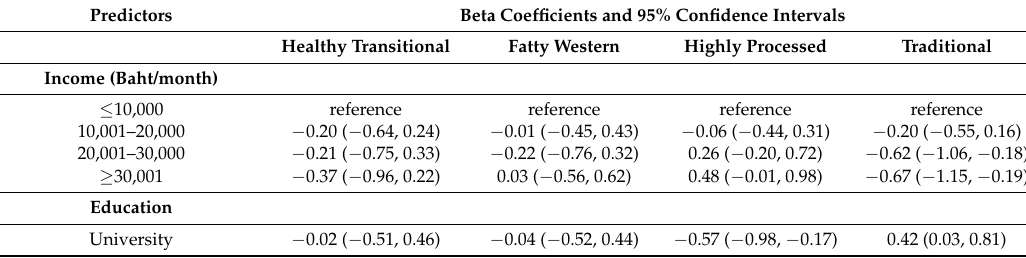
Table 3. Multivariable linear regression of socio-demographic predictors in 2013 and dietary intake pattern scores in 2015 in 589 Thai